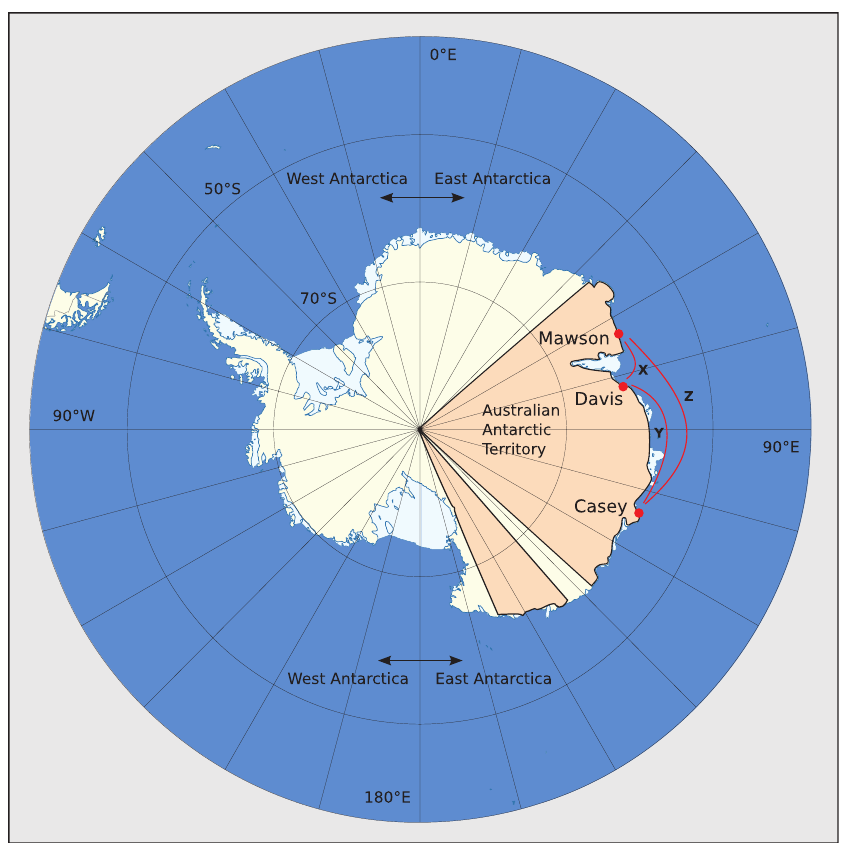
Figure 1. Sampling locations for Ade´lie penguin faeces. Sampling sites are named after the nearest Antarctic station. ‘Mawson’ samples were collected from Bechervaise Island (67 u 35 9 S, 62 u 49 9 E). ‘Davis’ samples were collected at Hop Island (68 u 50 9 S, 77 u 43 9 E). ‘Casey’ samples were collected at Whitney Point (66 u 16 9 S, 110 u 31 9 E) or at Blakeney Point (66 u 14 9 S, 110 u 34 9 E) which are 3.5 km apart. Approximate sea-route distances among sites are X , 700 km, Y , 1400 km and Z , 2100 km.